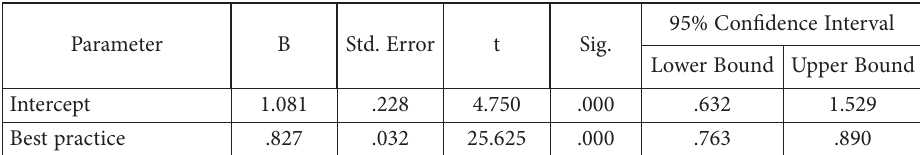
95% Confidence Interval Lower Bound Upper Bound